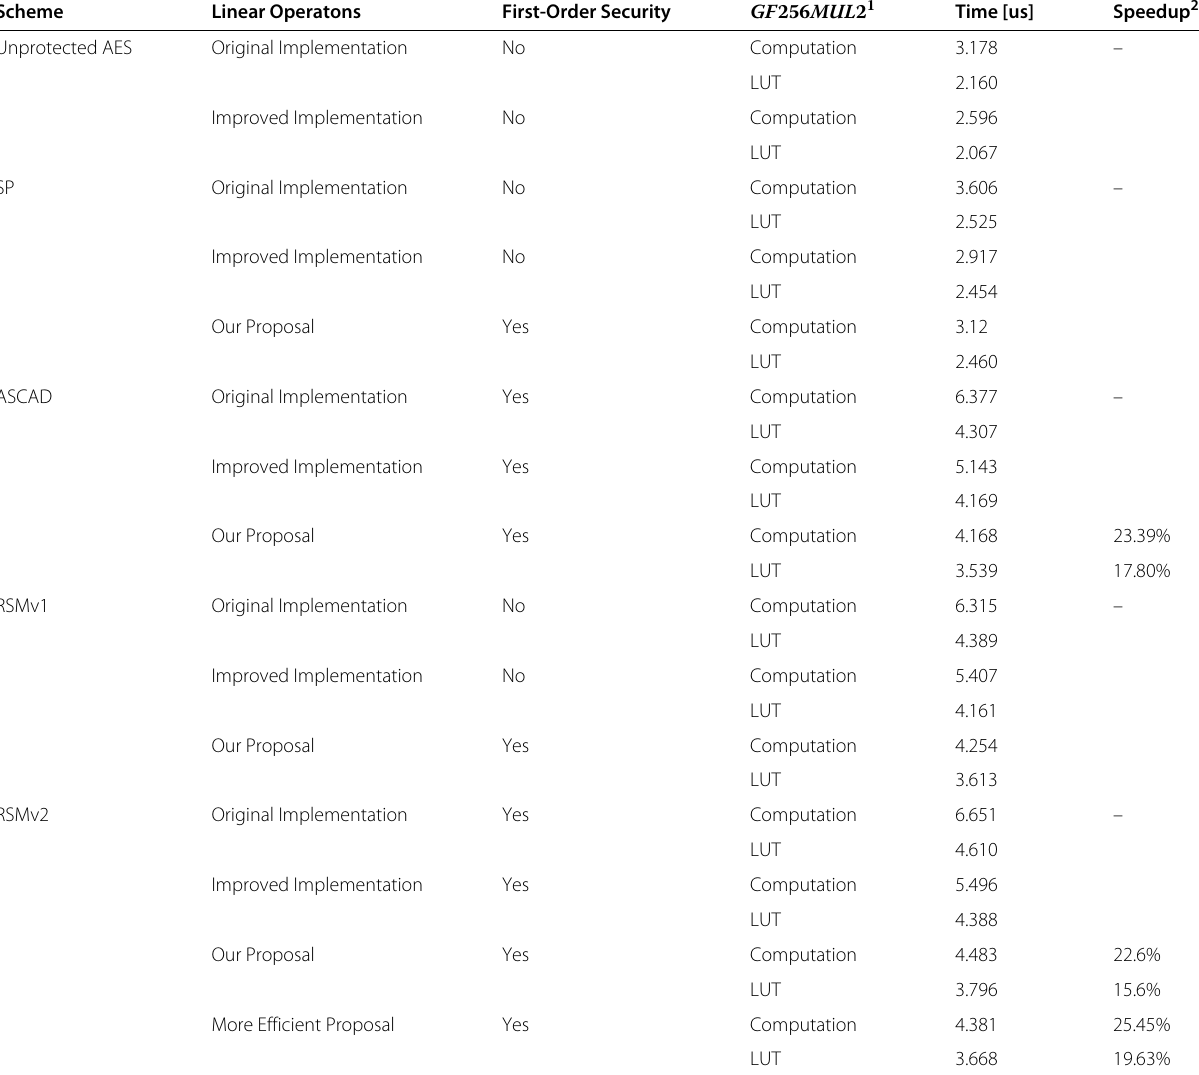
Table 4 Speedup in popular first-order masking schemes on an Intel Core i7-4790 CPU running at 3.60GHz Scheme